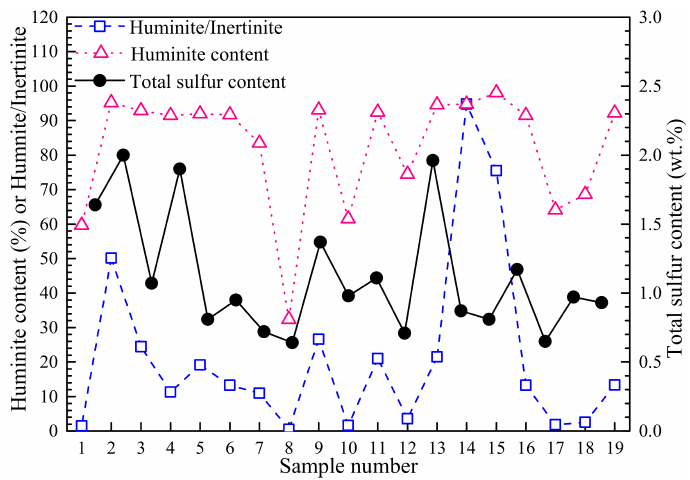
Figure 13. Matching relation between huminite and sulfur contents.